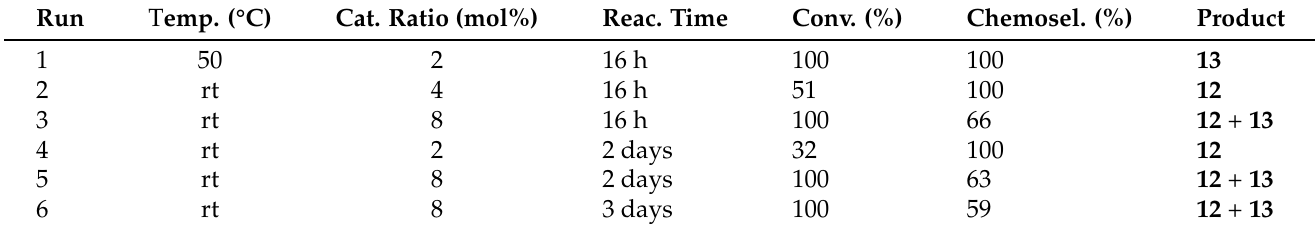
Table 3. Chemoselectivities and conversions of azidocarbonylation at atmospheric